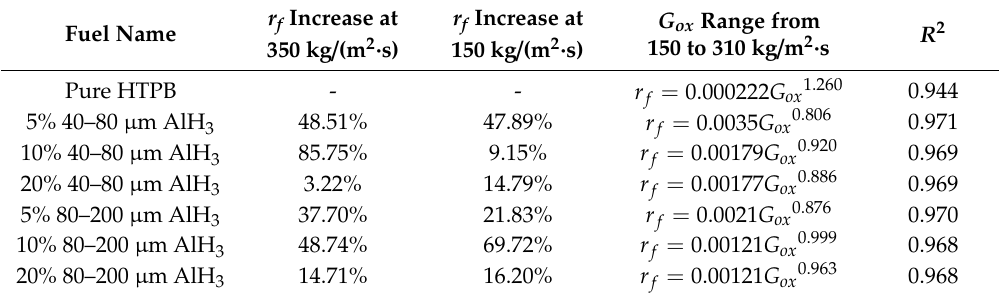
Table 10. r f increase and fitting results of r f / G ox curves for AlH 3 particles / HTPB composite fuels. Copyright Elsevier (2019). Reproduced with permission.